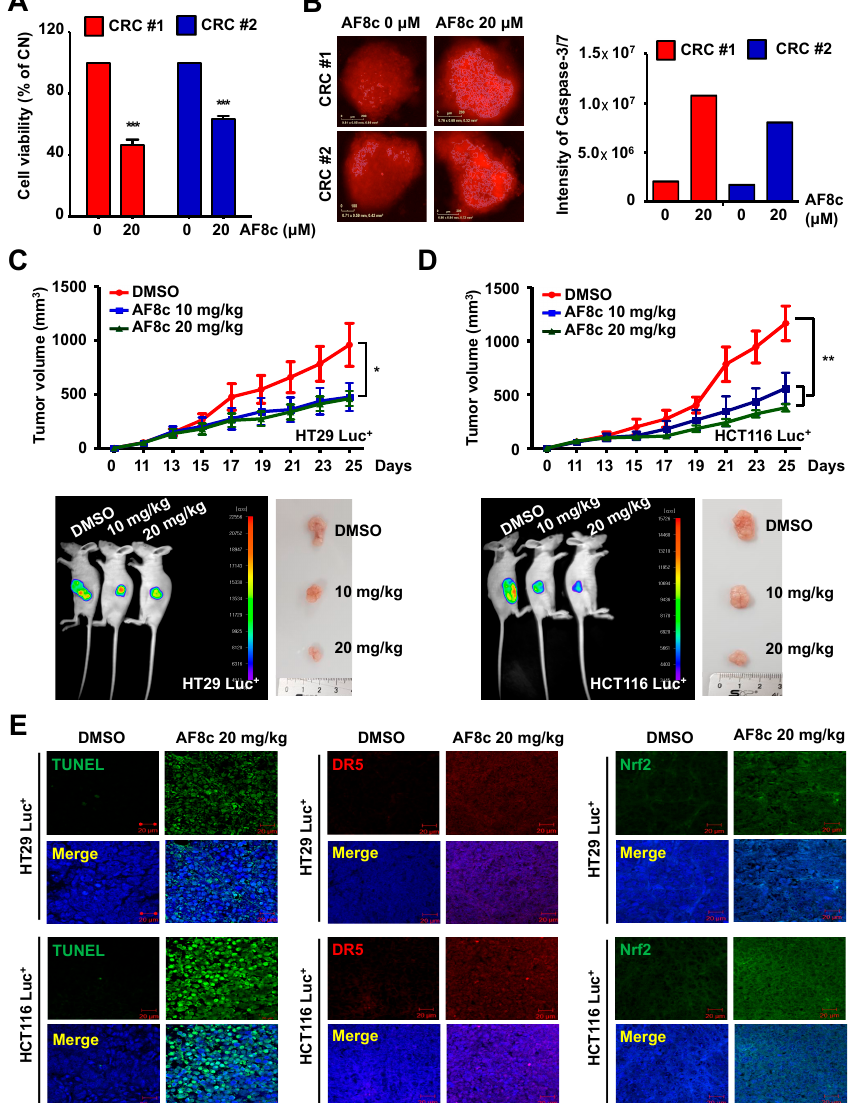
Figure 5. AF8c causes apoptosis by upregulating DR5, Nrf2, and CHOP expression in PDC cells and in vivo: ( A ) PDC cells were treated with AF8c for 24 h. Then, cell viability was measured by WST-1 assay. **, p < 0.01 and ***, p < 0.001; ( B ) the spheroid shapes were photographed with an optical microscope. After AF8c treatment, caspase 3/7 dye was added to the media and placed into an In- cuCyte ZOOM for 3 days. Then, caspase 3/7 fluorescence intensity using either the IncuCyte Live- Cell (left) or ImageJ (right). Scale bar, 100 μ m; ( C , D ) Subcutaneous injection of HT29 Luc + ( C ) and HCT116 Luc + ( D ) cells into the flanks of BALB/c nude mice. The upper panel indicates tumor volume in xenografts of nude mice while the lower-left panel illustrates the images of tumors obtained using a charge-coupled camera from the in vivo imaging system. The lower-right panel shows the tumor tissue isolated from xenograft nude mice photographed with a digital camera. *, p < 0.05 and **, p < 0.01. ( E ) Representative fluorescence images showing TUNEL assay results (left), Nrf2 (middle), and DR5 (right). The stained tissues were imaged using a confocal fluorescence microscope. Scale bar, 20 μ m.